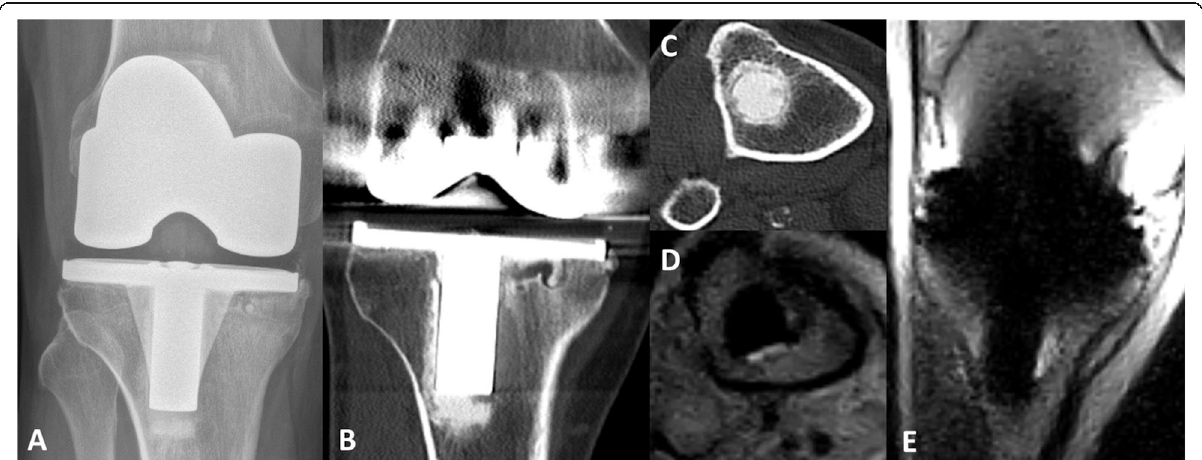
Fig. 5 Loosening of the tibial component. The conventional radiograph ( a ) of patient 6 shows tibial component loosening around the medial plate and stem. CT ( b and c ) and low-field MRI ( d and e ) show images of the same knee, where images c and d are the transversal views of b and e at the most distial point of the tibial stem. The CT shows lucency ( b - c ) and MRI effusion ( d - e ) around the tibial stem, which are elements suspected of loosening the tibial